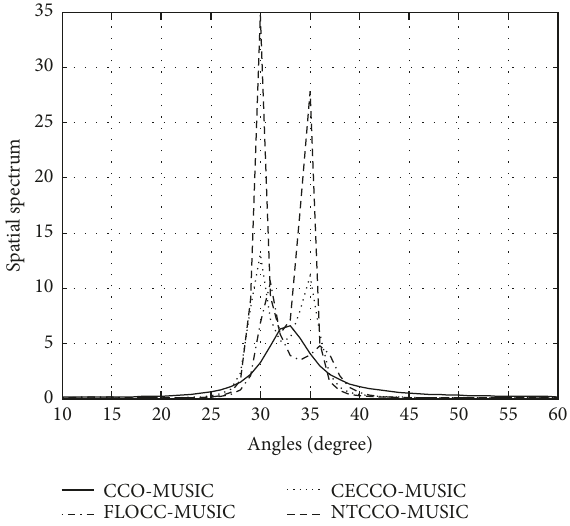
Figure 2: Spatial spectrum of the